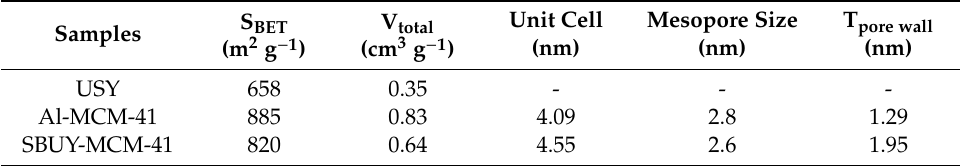
Table 1. Surface area and pore volume data for Al-MCM-41 and SBUY-MCM-41.